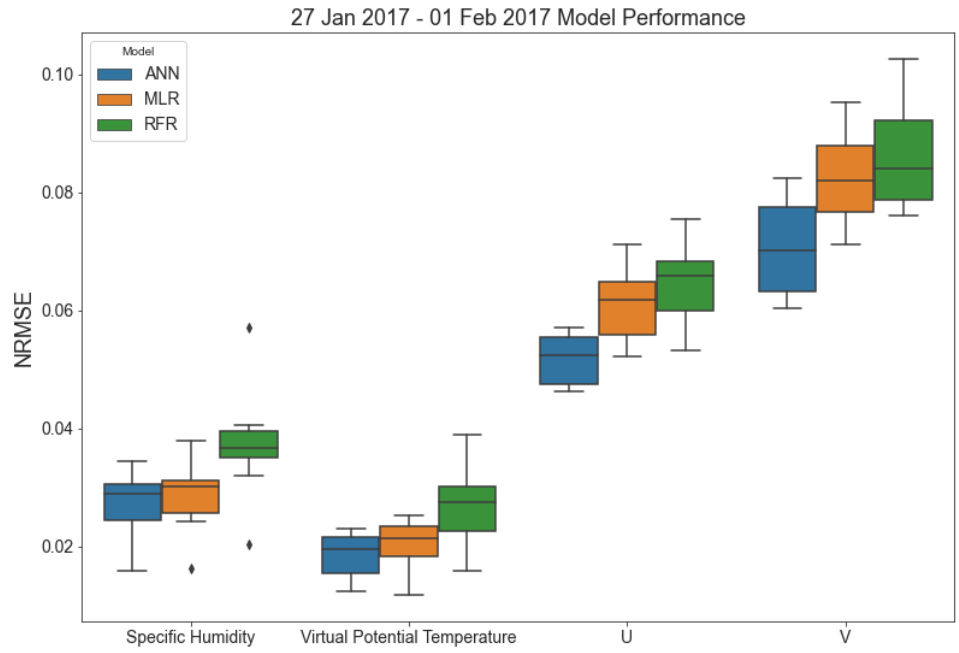
Figure A7. Same as Figure 4 but including the random forest